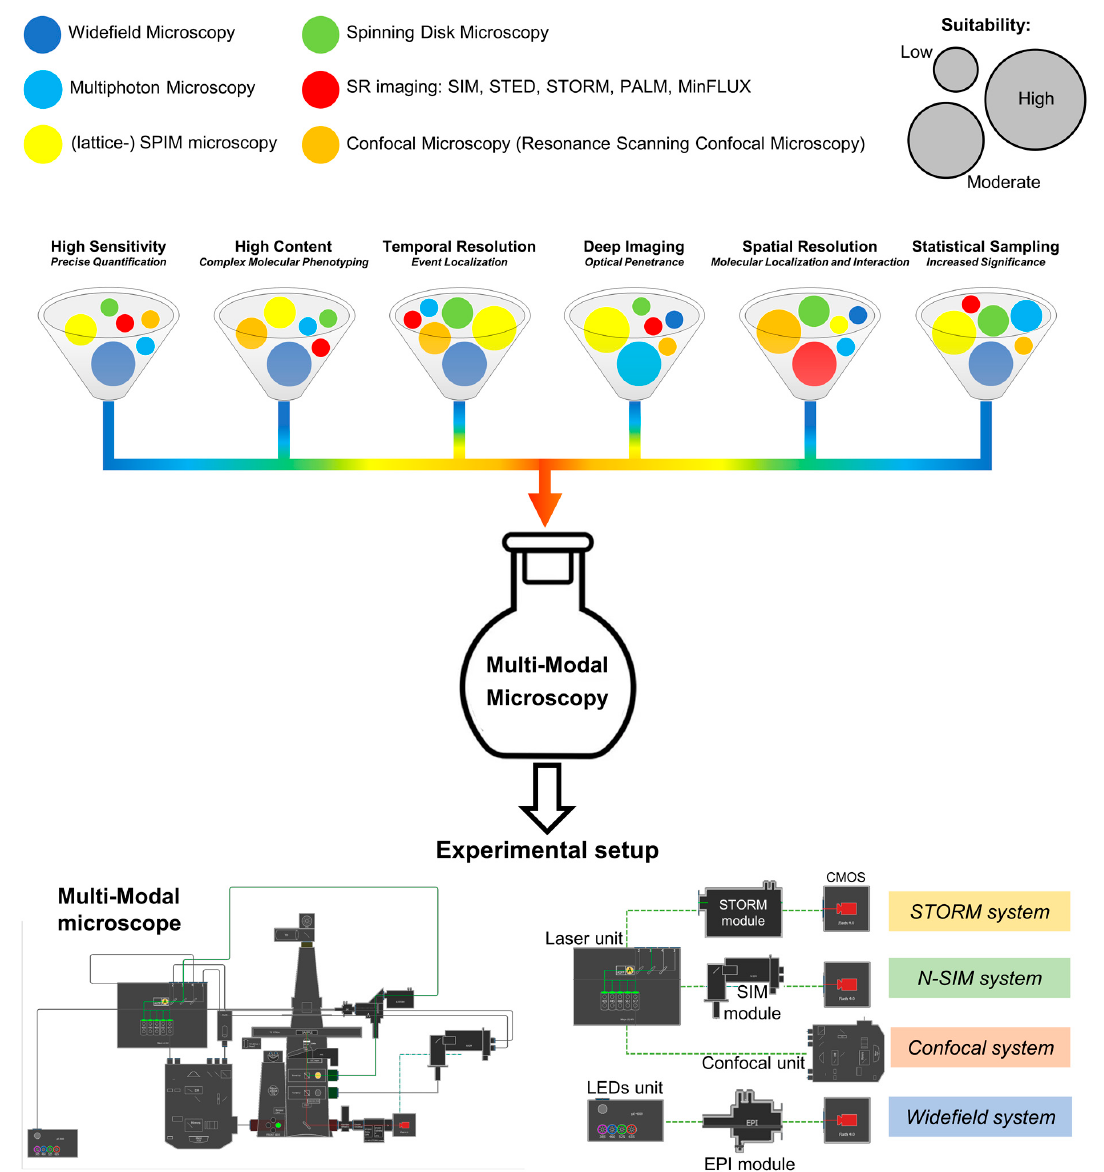
Figure 1. Correlative Multi-Modal Microscopy. Every fluorescence microscopy technique shows different performances (low, moderate, high) according to the considered resolution (e.g., spatial, temporal, statistical sampling). Multi-Modal Microscopy can overcome these limitations by combining the different technologies as shown in the set ‐ up employed in this work.